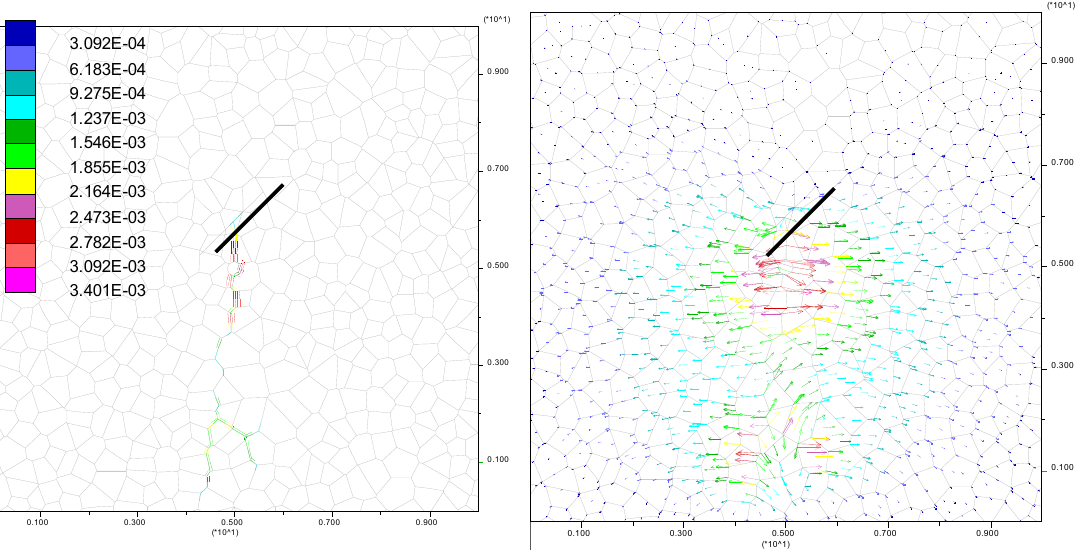
Figure 4. Opening mode in numerical modeling with an incidence angle of 45 degrees under low differential stresses of 1 MPa